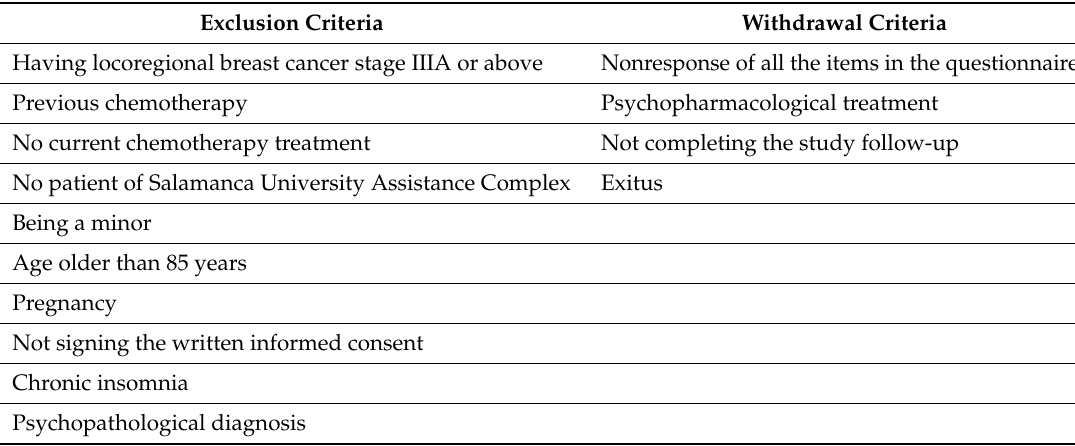
Table 1. Exclusion and withdrawal